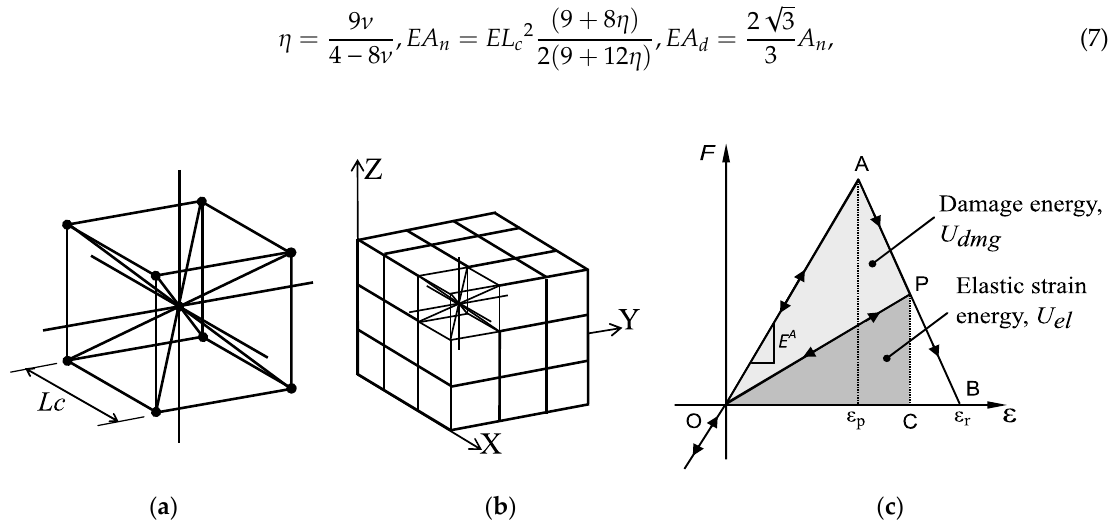
Figure 18. The lattice discrete element method (LDEM); ( a ) basic cubic module, ( b ) generation of a prismatic body, and ( c ) bilinear constitutive model where the damage is taken into account.